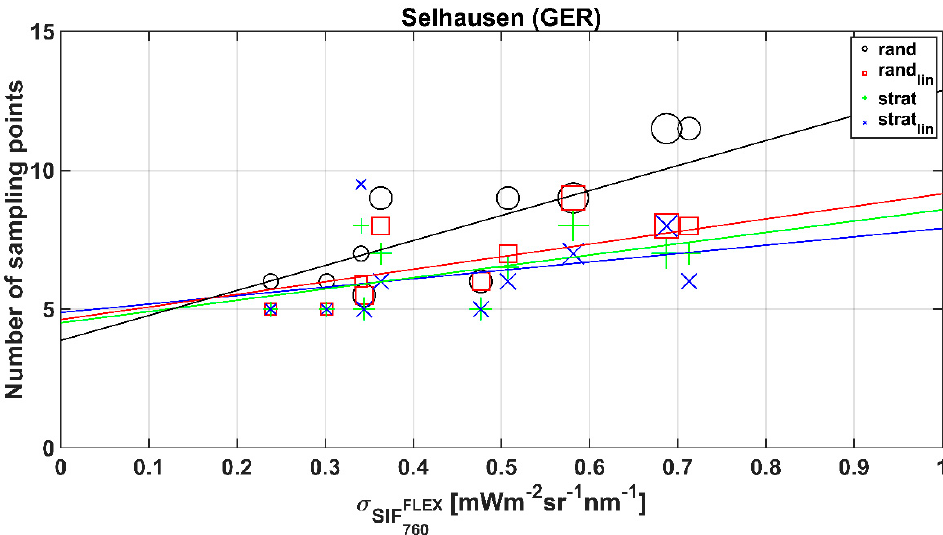
Figure 6. The 95th percentile of the number of sampling points needed to meet the T10 thresholds for the FLEX pixels in Selhausen (Germany) experimental site using a random sampling, a random sampling with a linear combination model, a stratified random sampling and a stratified random sampling with a linear combination model. The number of sampling points is shown in relation to σ . The pointer size is related to the number of components within each FLEX pixel (2–4). The solid lines show the linear OLS regressions for each sampling strategy.